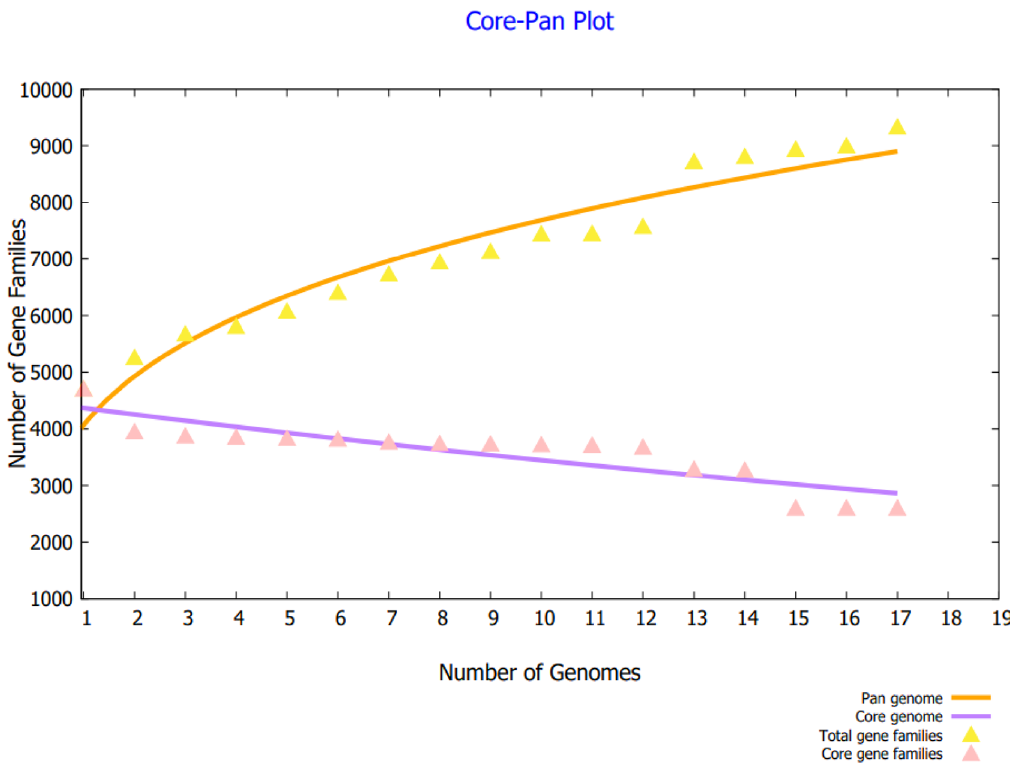
Figure 2. Core pan plot of K. aerogenes